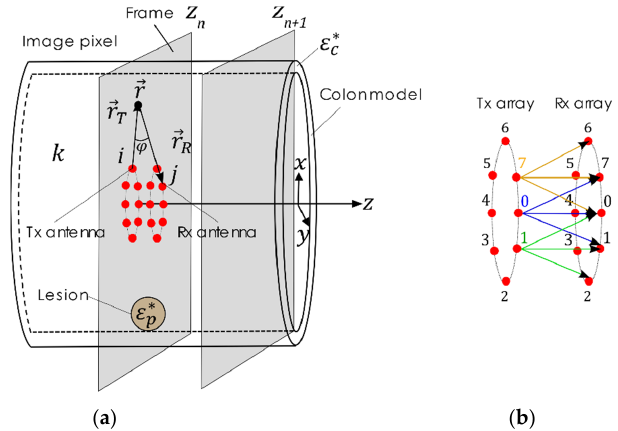
Figure 5. Geometry of the imaging problem: ( a ) schematic of the ex vivo colon model with a lesion of complex permittivity ε p ∗ and the acquisition array moving along the z-direction in the colon lumen. ( b ) Transmitting and receiving array configuration, e.g., for the transmitter i = 0, a measurement is taken with the 3 closest receiving antennas, 𝑗 = 7,0,1 depicted in blue, for the transmit- ter 𝑖 = 1 a measurement is taken with antennas 𝑗 = 0,1,2 depicted in green, for the transmitter 𝑖 = 7 a measurement is taken with the antennas, 𝑗 = 6,7,0 in orange. A three-step algorithm is used to obtain the output, i.e., the acoustic signal when a polyp is detected, for each measured frame 𝑛 .